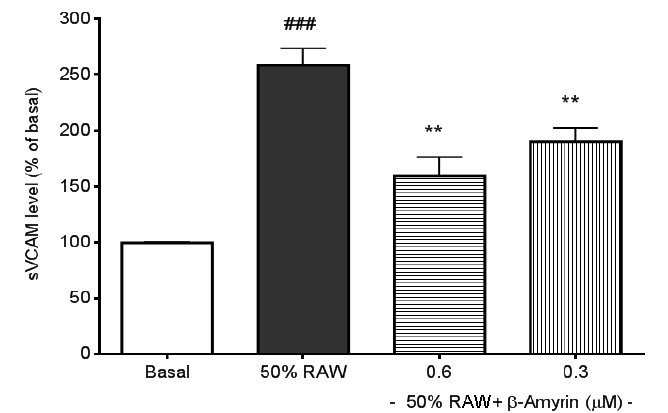
Figure 4. Effects of β -amyrin on proinflammatory cytokine-induced sVCAM-1 production. SVEC4-10 endothelial cells ( n = 8) were treated with 50% RAW conditioned medium with and without β -amyrin (0.6 and 0.3 µM) for 6 h prior to sVCAM-1 concentration being measured. Statistics are shown for 50% RAW conditioned medium-treated cells ### p < 0.005, compared to the basal; 0.6 and 0.3 µM of β -amyrin. ** p < 0.01 compared to 50% RAW conditioned media-treated